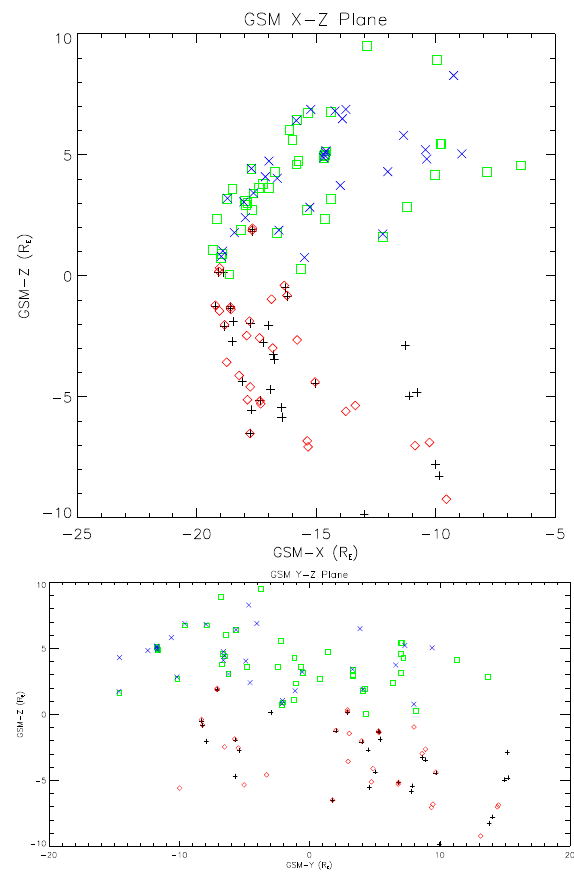
Fig. 8. The distribution of all the passages of the spacecraft from the lobe into the plasma sheet and vice versa in the GSM–YZ and GSM–XY planes. Expansion crossing are marked by green squares and black plus signs for the north and south lobes, respectively. Thinning crossings are indicated by blue crosses and red diamonds in the north and south lobes, respectively. The data points are evenly distributed over the GSM–YZ